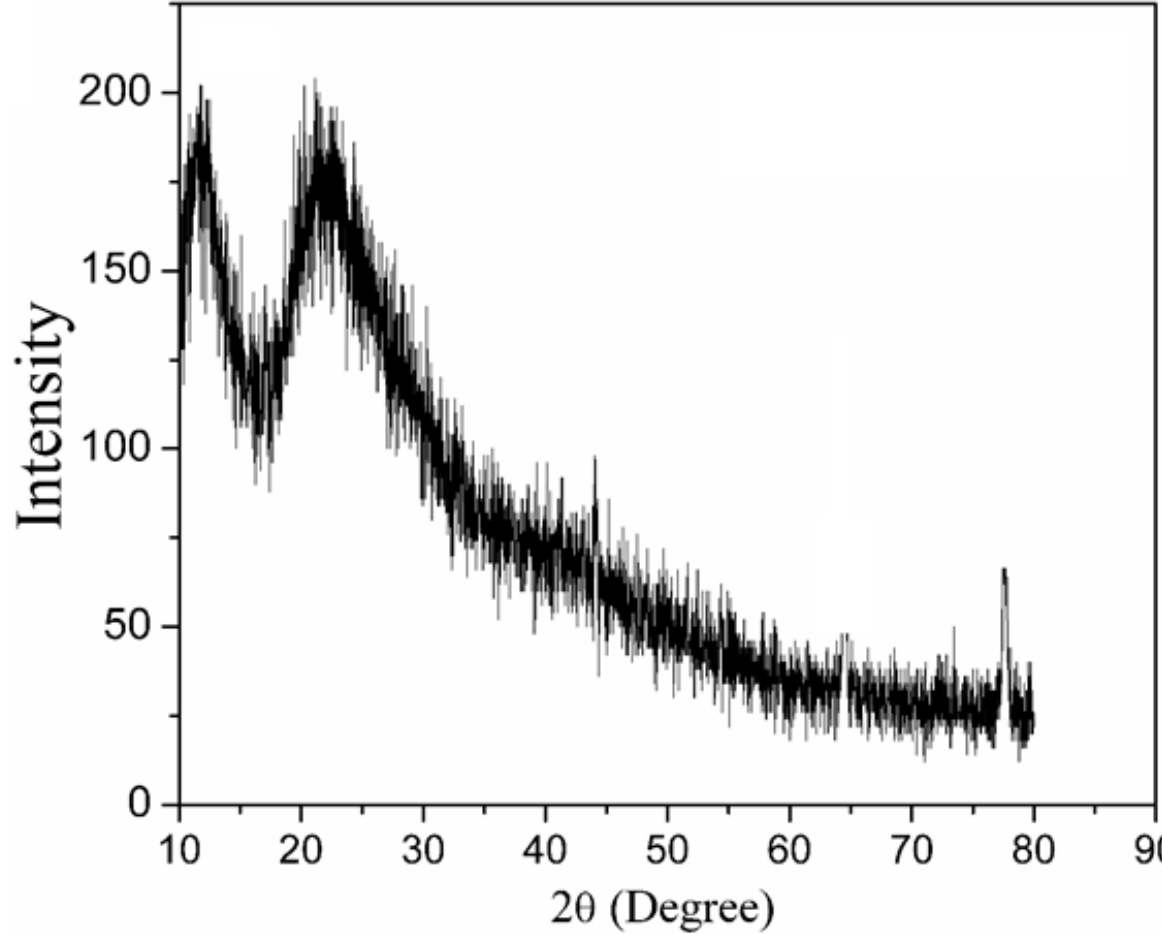
Figure 3. X-ray diffraction of the uncalcined sample at room temperature.